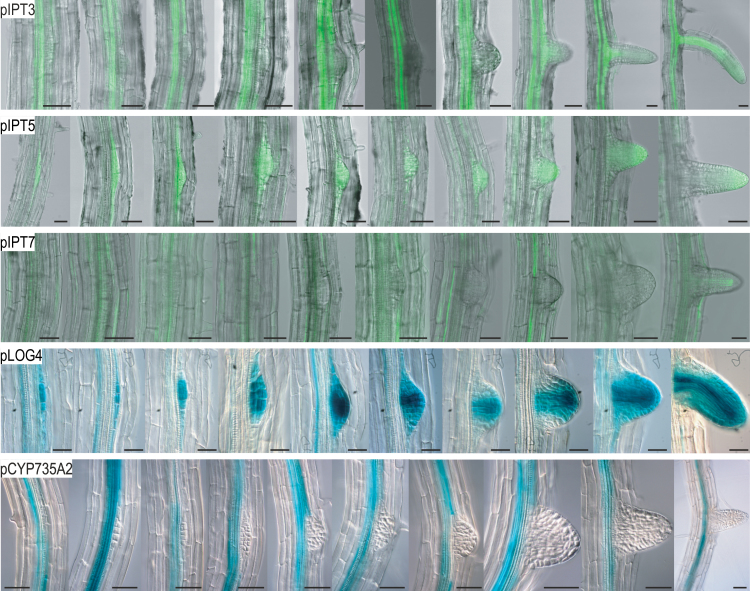
Spatio-temporal expression of selected cytokinin synthesis genes during LR development. A developmental sequence of the expression pattern of promoters of cytokinin metabolism genes is shown from left to right starting with stage I LRP to emerged LR. The respective promoter is indicated in the upper left corner of each picture series. Three-day-old seedlings were stained with GUS reaction buffer for 1h and cleared. GFP expression was analysed in 5-d-old seedlings using a confocal laser scanning microscope. Part of the root staining pattern reporting expression of the cytokinin metabolism genes shown here have been published before (Werner et al., 2003; Takei et al., 2004b
; Kuroha et al., 2009; Kiba et al., 2013). Scale bars is 50 μM (this figure is available in colour at JXB online).